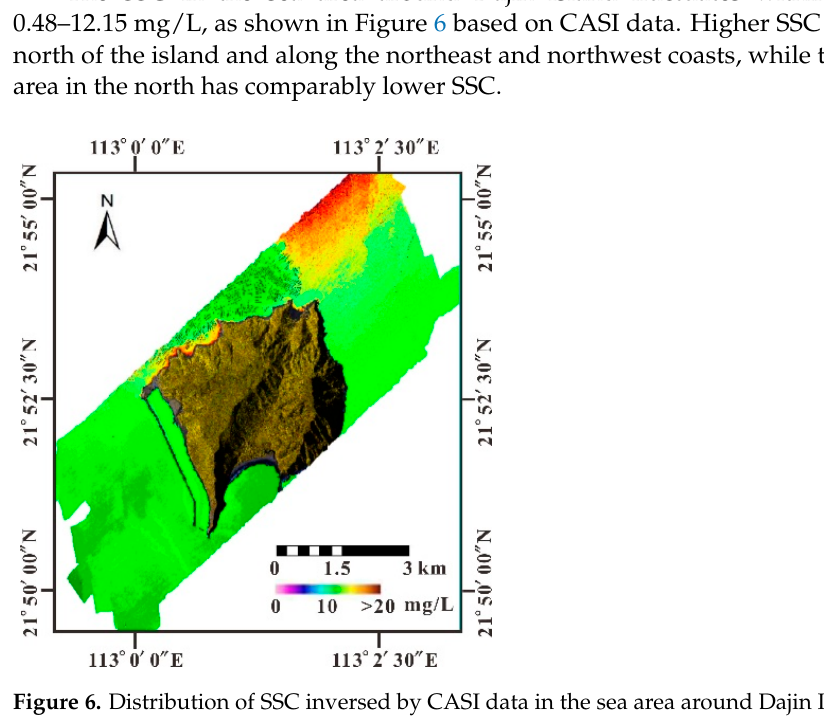
Figure 7. Distribution of SSC inversed by MODIS in the Pearl River Estuary (the red box is the cov- erage of the CASI image).